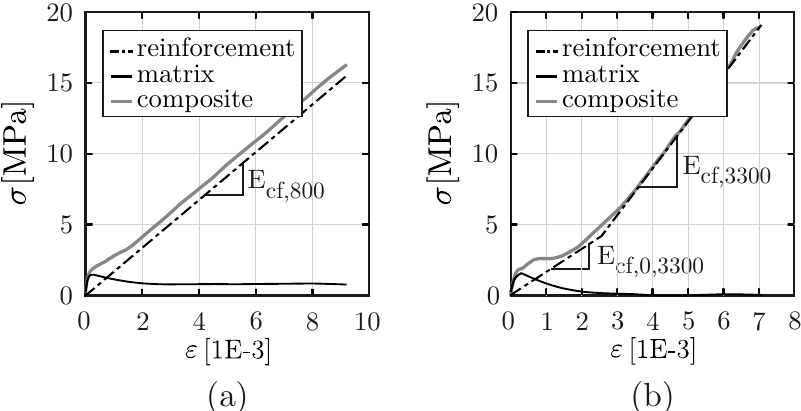
Figure 11. Stress–strain curves of the matrix (black solid lines), reinforcement (dashed lines) and composite (grey solid lines) for cross sections with ( a ) 800 tex and ( b ) 3300 tex